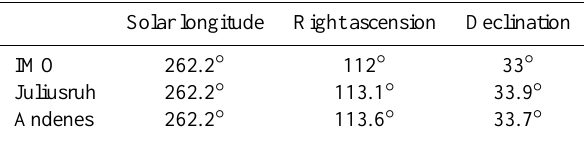
Table 3. Comparison of IMO reference source radiant position to the meteor radar observations. The Juliusruh and Andenes radiant positions are not corrected for zenith attraction.